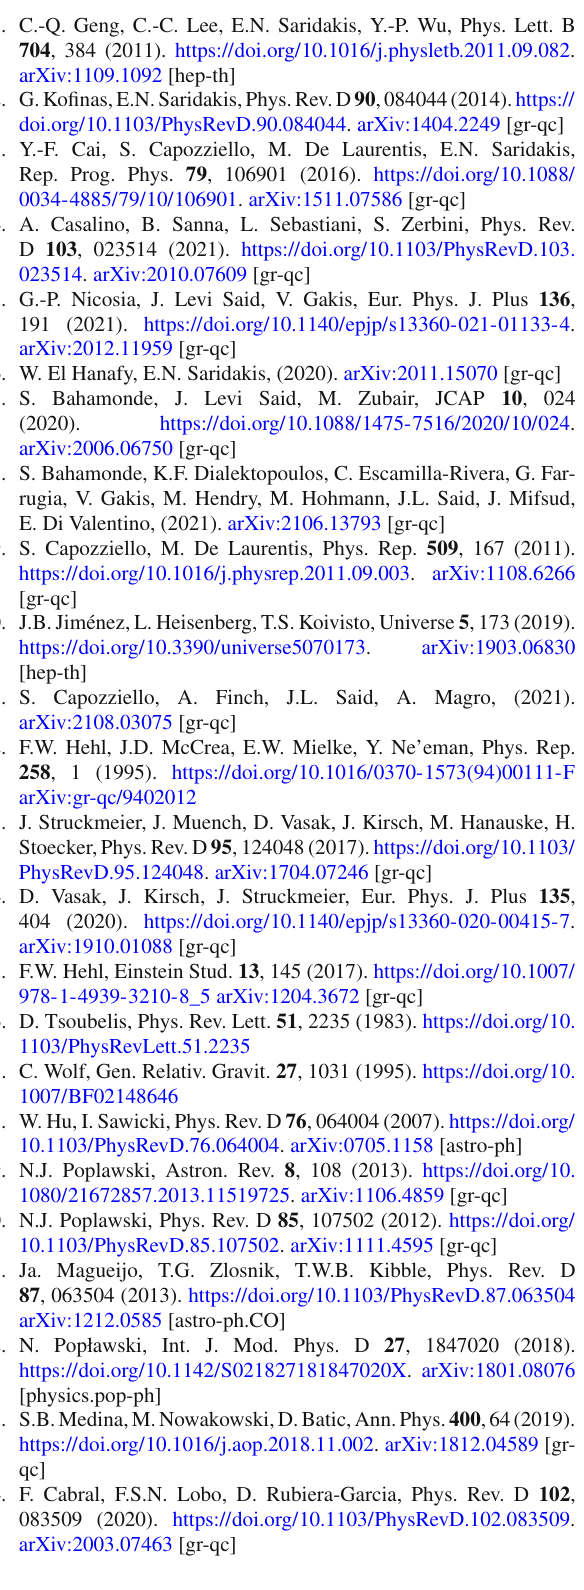
Table 1 The posterior distribution for the best fit of BBN + CC + SC Parameter Torsional